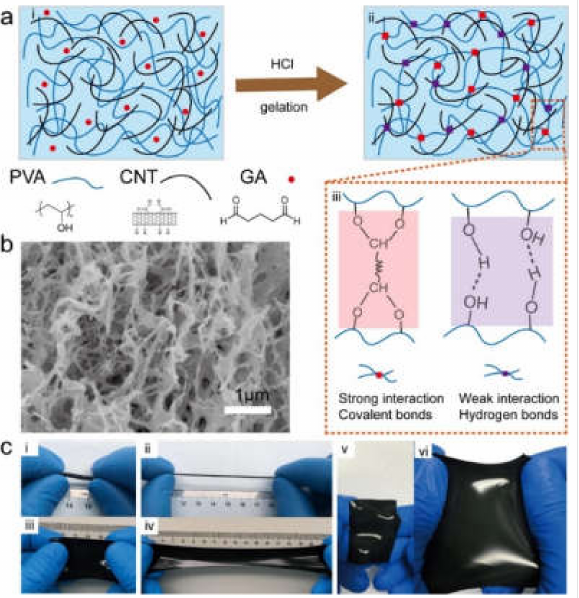
Figure 7. ( a ) Schematic hydrogelation process. ( b ) SEM image of the hydrogel. ( c ) Stretching of the elastic material. Reproduced with permission from Wang, H. et al. (2020) [149] © 2021 Elsevier. Fibrous components are very attractive for wearable electronics as mentioned